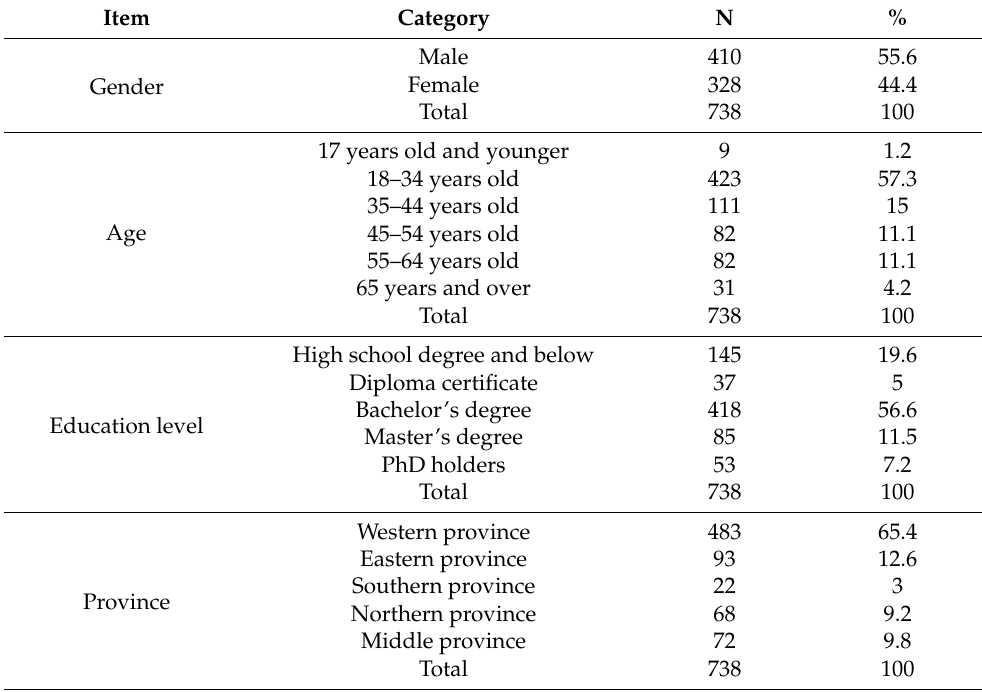
Table 1. Demographic characteristics of the